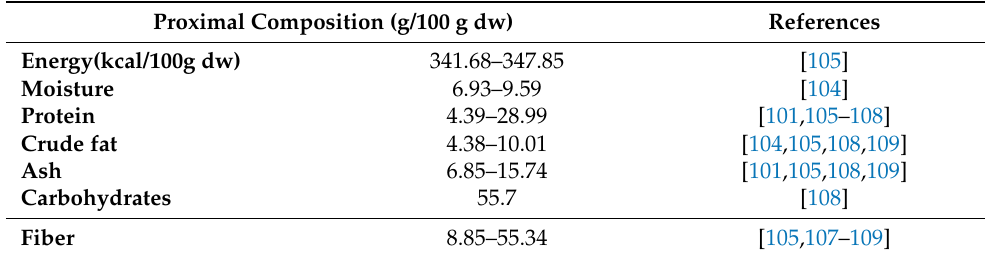
Table 3. Energetic value, proximate composition, fatty acids, and micro and macro elements of Brassica oleracea L. var. italica